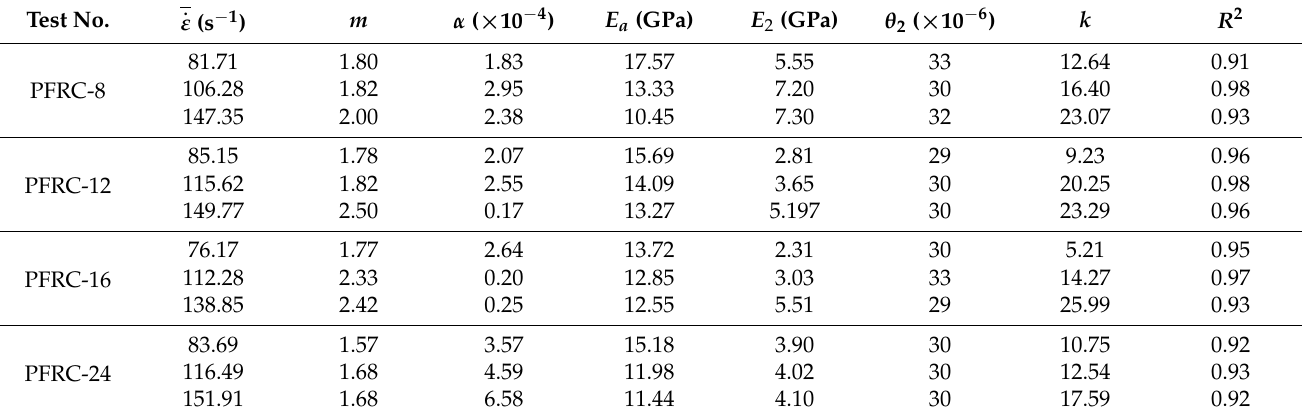
Figure 15. Influence of m and α on damage factors: ( a ) α as a fixed value and ( b ) m as a fixed value.